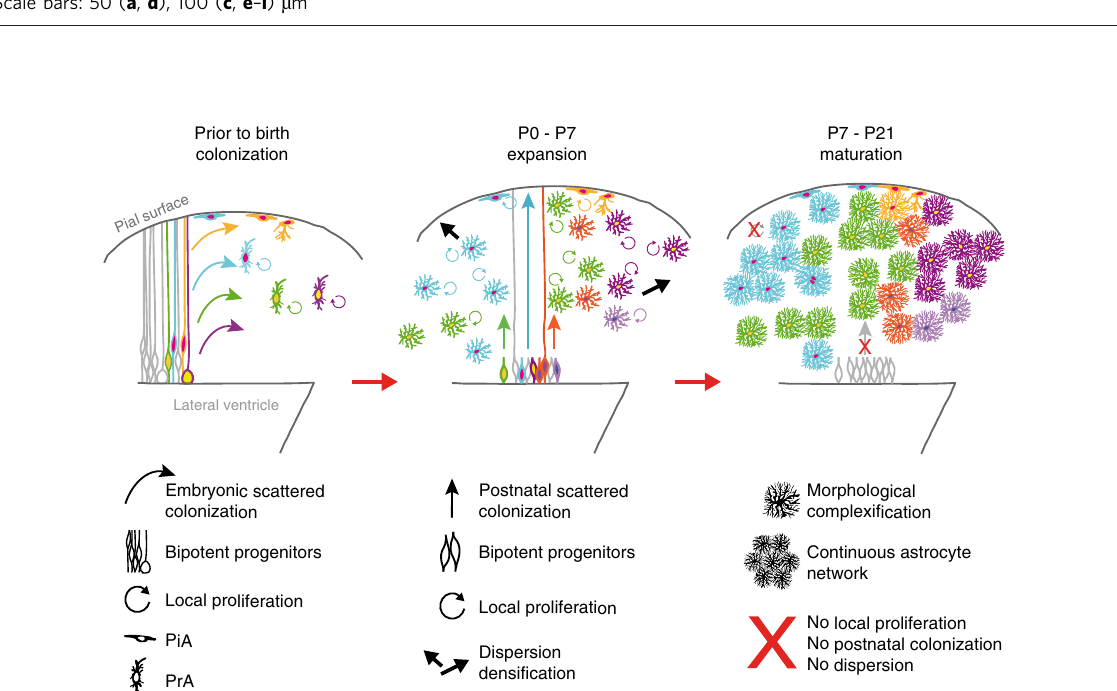
Fig. 5 Cortical astrocytes arise from Olig2 + seeding units issued from both pre- and postnatal progenitors. a MM electroporated at E15 colocalize with Olig2 marker at P1 (stars in bottom image) but not with S100 β (top). b The percentage of Olig2 + cells among MM-labeled cells increases from 5% at E18 to 10% at P0 and is then stable until P1, while no MM + /S100 β + cell is detected at these stages. c IUE of MM in Olig2 Cre mice at E13 results in labeling of astrocyte-like cells at P7 both at the pial surface and in the cortical parenchyma. d Example of a P7 MM-labeled clone occupying three consecutive serial sections comprising S100 β + , Aldh1l1 + , and Olig2 + cells, revealed by immunostaining. e IUE of MM in E13 Olig2 Cre embryos yields sparse recombined cells